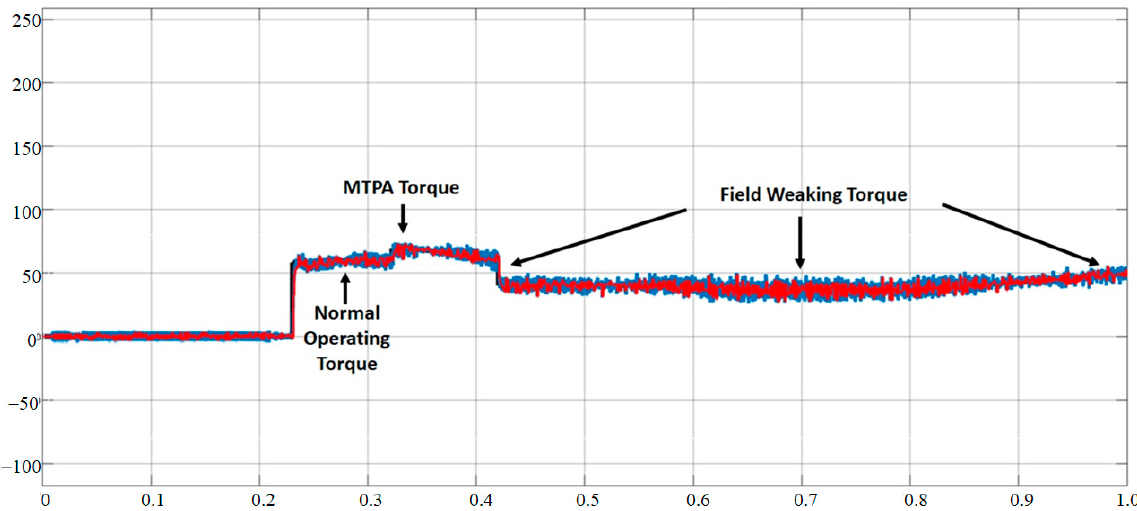
Figure 11. Torque output of the IPMSM using the proposed lookup table-based controller.